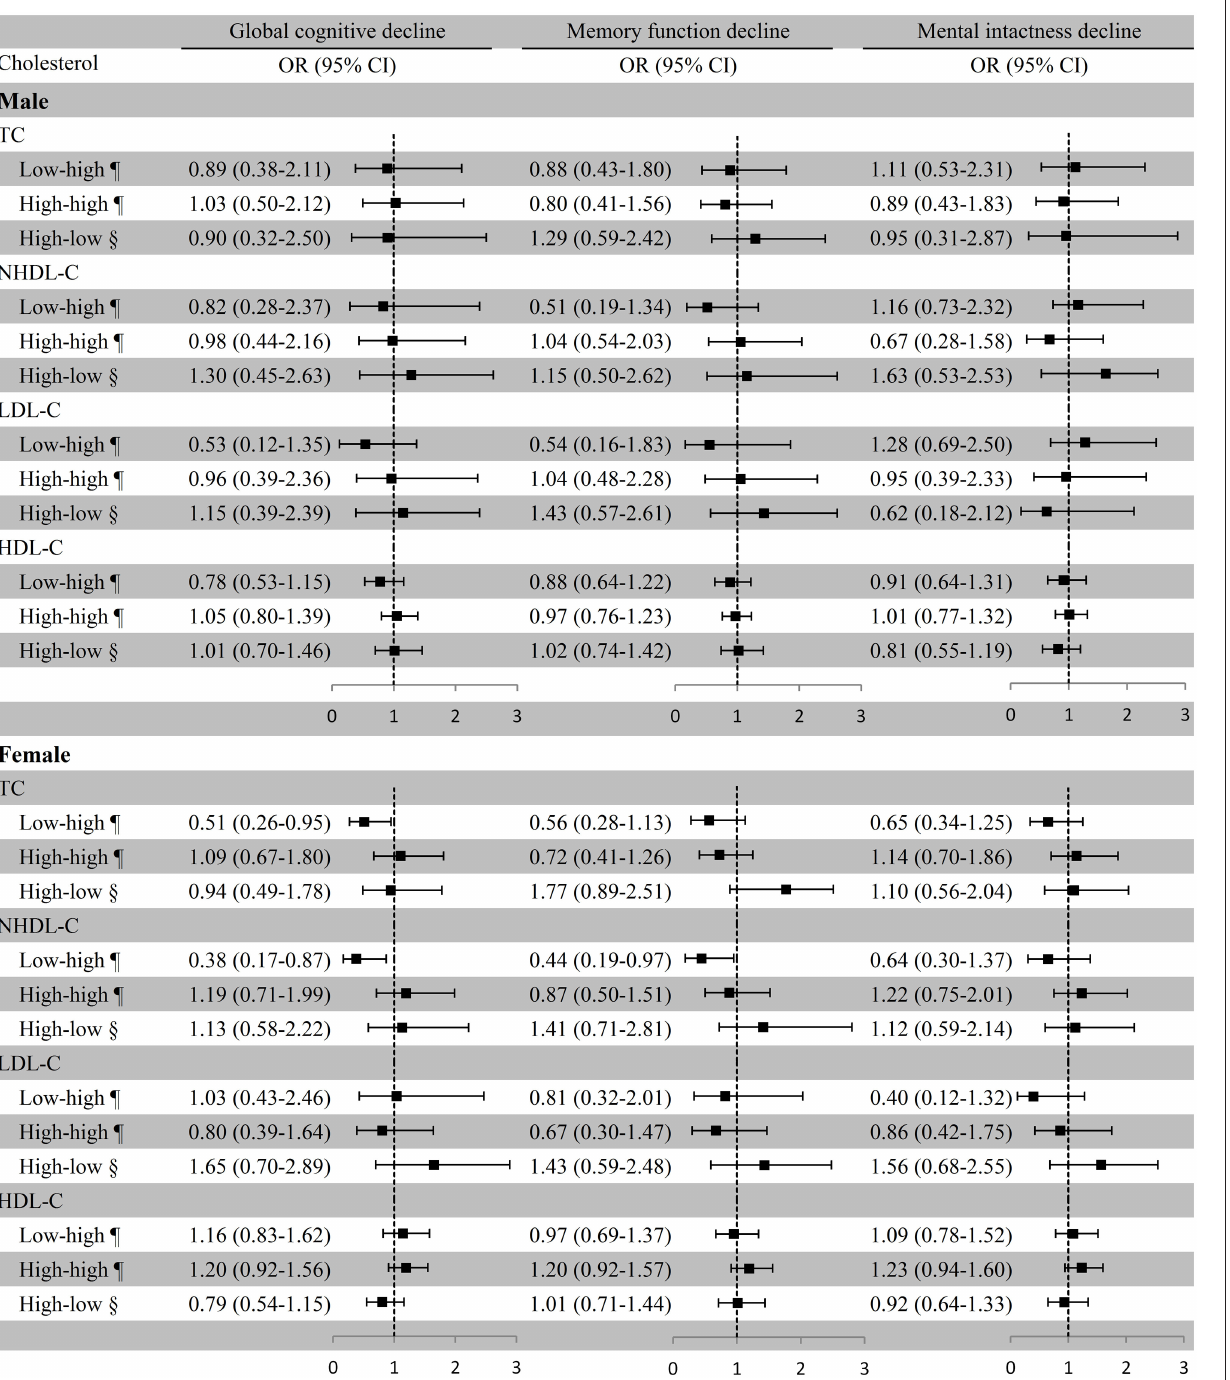
FIGURE 4 | Association between cholesterol variation and cognitive decline in sex subgroups. ¶ Take the low–low group as a reference; § Take the high–high group as a reference. Baseline age, education, marital status, smoking, drinking, BMI, exercise, physical diseases, medication use (antihypertensive or antidiabetic medications), and the number of comorbidities were adjusted. Menstrual status was also adjusted in the female subgroup. TC, total cholesterol; NHDL-C, non-high-density lipoprotein cholesterol; LDL-C, low-density lipoprotein cholesterol; HDL-C, high-density lipoprotein cholesterol; OR, odds ratio; CI, confidence interval. risk of dementia (Mielke et al., 2010). In a birth cohort study documented in Swedish females, in which the greatest decrease in TC (refers to the lowest quartile of TC difference) after 32 from Germany, TC level from baseline to endpoint decreased years of follow-up is associated with a 2.37-fold increase in the in participants with Alzheimer’s disease but remained stable in